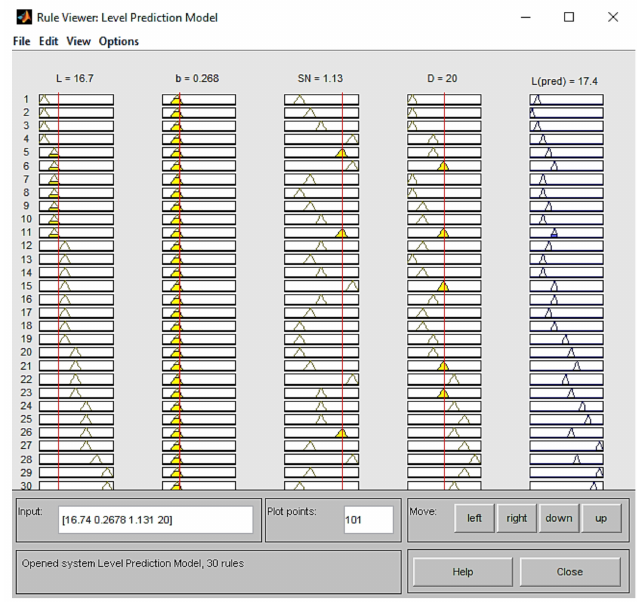
Figure 6. The rule viewer in the MATLAB